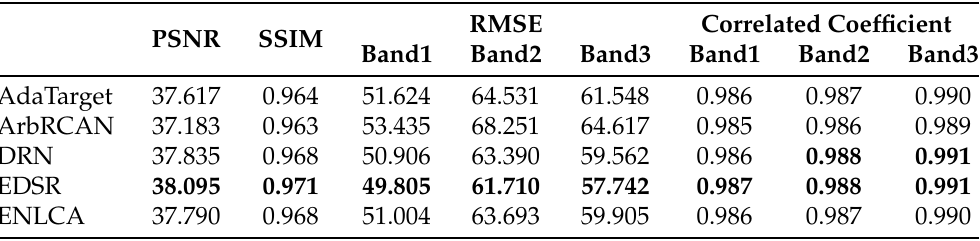
Table 5. Radiometric and structural evaluation on FY4ASRcolor with re-trained parameters.